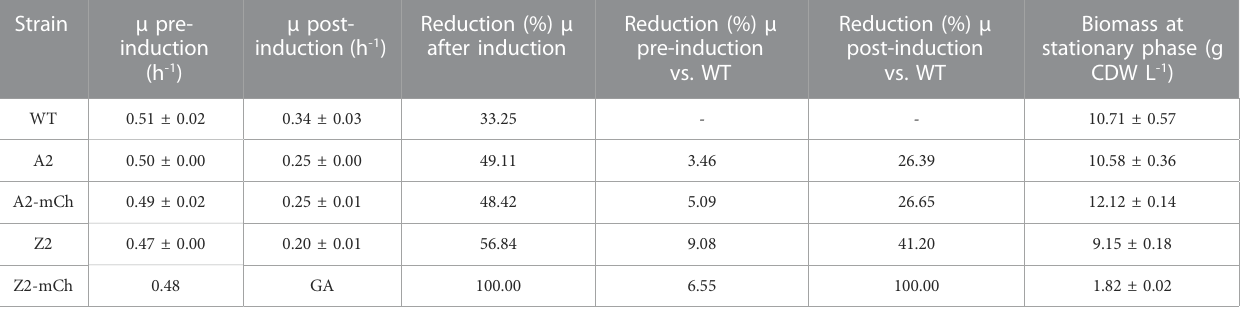
TABLE 3 Summary of results from batch cultivations in Applikon benchtop bioreactors. The table shows the speci fi c growth rates (µ; h -1 ) at exponential phase before (pre-induction) and after (post-induction) addition of m-toluate (average ±SD); reduction (%) in µ occurred after induction in the same strain and cultivation; reduction (%) in µ pre- and post-induction, referred to WT; and biomass (g CDW L -1 ) at stationary phase (average ±SD).